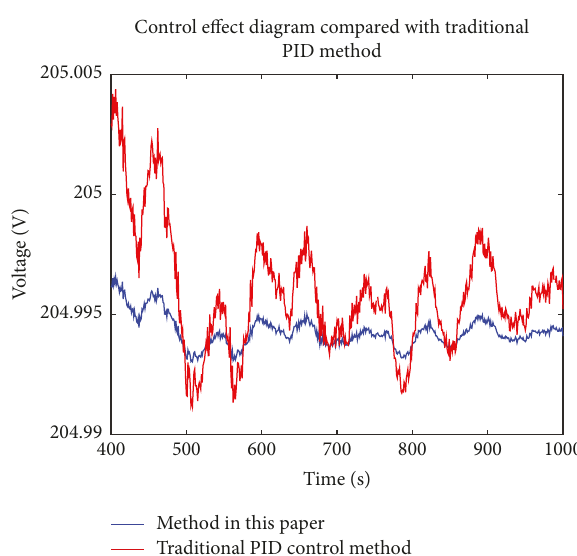
Figure 8: Switching control sequence.